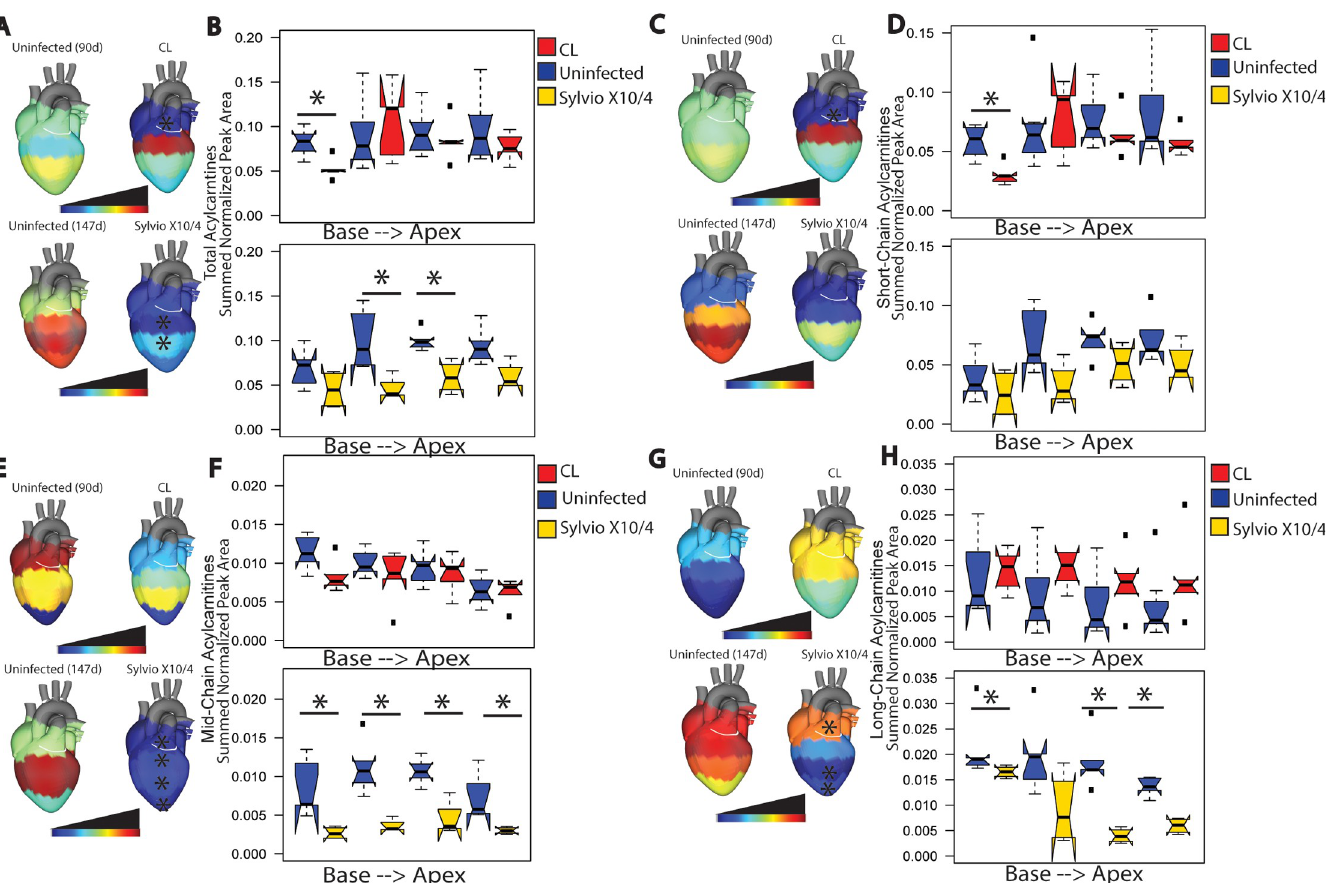
Fig 3. Spatial impact of chronic T . cruzi infection on cardiac acylcarnitines. Normal levels and distribution of acylcarnitines are represented by uninfected samples. (A, B) Differential total acylcarnitine distribution between uninfected and infected heart sections for both CL and Sylvio X10/4 strains. CL-infected mice showed statistically significant decreases in total acylcarnitine levels at heart base when compared to uninfected mice ( � , p < 0.05 by Mann-Whitney test). (C, D) CL-infected mice showed statistically significant decreases ( � , p < 0.05, by Mann-Whitney test) in short-chain acylcarnitine ( � C4) at heart base. (E, F) Sylvio X10/4-infected mice showed statistically significant decreases in mid-chain acylcarnitines at all positions compared to uninfected mice. ( � , p < 0.05 by Mann-Whitney test). (G, H) Sylvio X10/4-infected mice showed statistically significant decreases in long-chain acylcarnitines ( � C12) at most heart positions compared to uninfected mice ( � , p < 0.05 by Mann-Whitney